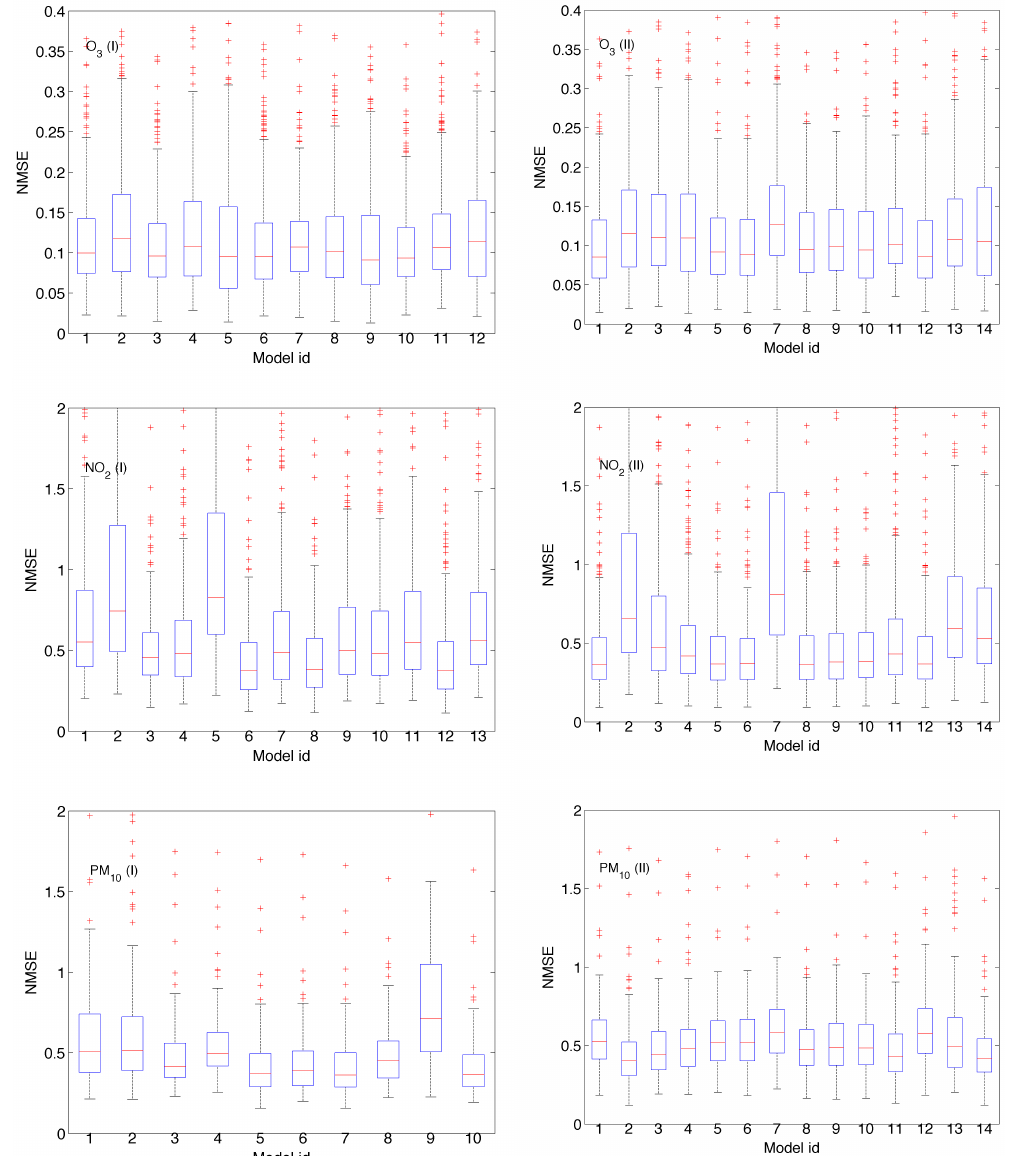
Figure 2. Model skill difference via the NMSE. For each box, the central mark indicates the median, and the bottom and top edges of the box indicate the 25th and 75th percentiles respectively. The whiskers extend to the most extreme data points not considered outliers and the outliers (points with distance from the 25th and 75th percentiles larger than 1.5 times the interquartile range) are plotted individually using the “ + ”